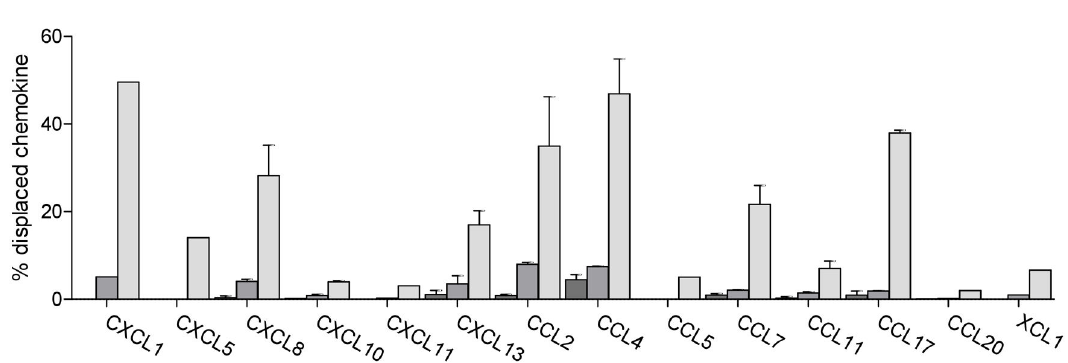
Figure 8. CCL18 displacement of heparin bound chemokines. Heparin bound chemokines were displaced by 10 nM (dark gray), 100 nM (gray) and 1 µM (light gray) CCL18. Chemokines in the supernatants were detected using the Luminex technology. Amount of chemokine displaced by 5 M NaCl is set to 100% and data are expressed as % of displaced chemokine. Graph represents the mean ± SEM. Data for CXCL8, 10, 13, CCL2, 4, 7, 11 and 17 represent two independent experiments. Using 1 µM CCL18 as competitor a displacement of up to 50% GAG-bound chemokine was obtained.